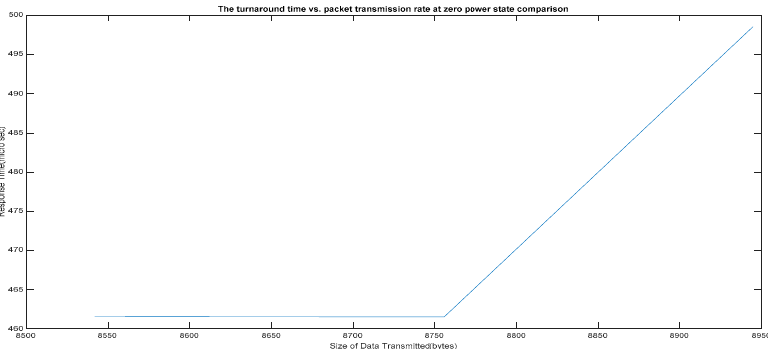
Figure 13. Response time in relation to transmitted data size.